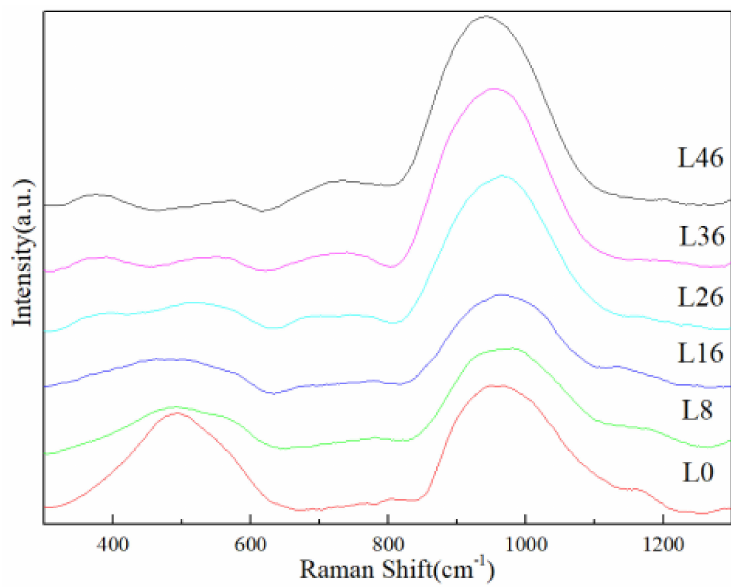
Figure 3. Raman spectra of basaltic glasses from L0 to